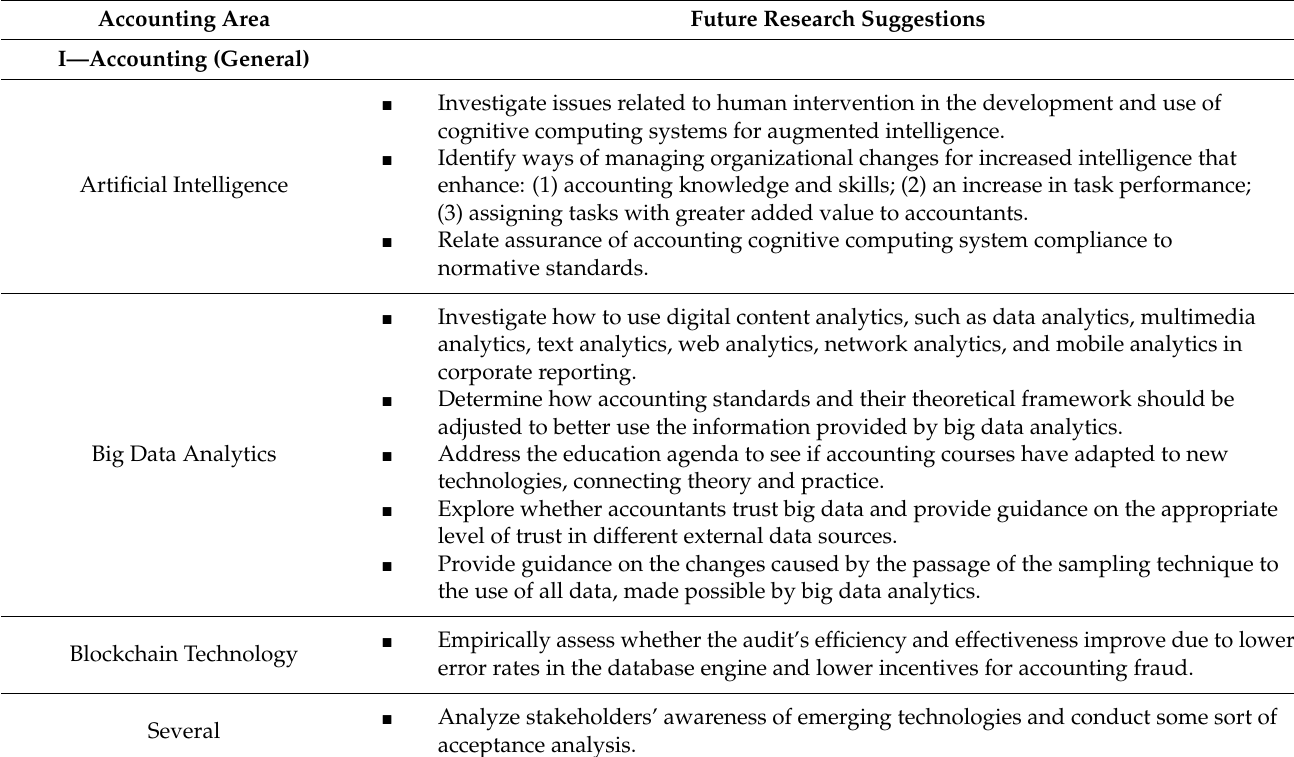
Table 6. Future research